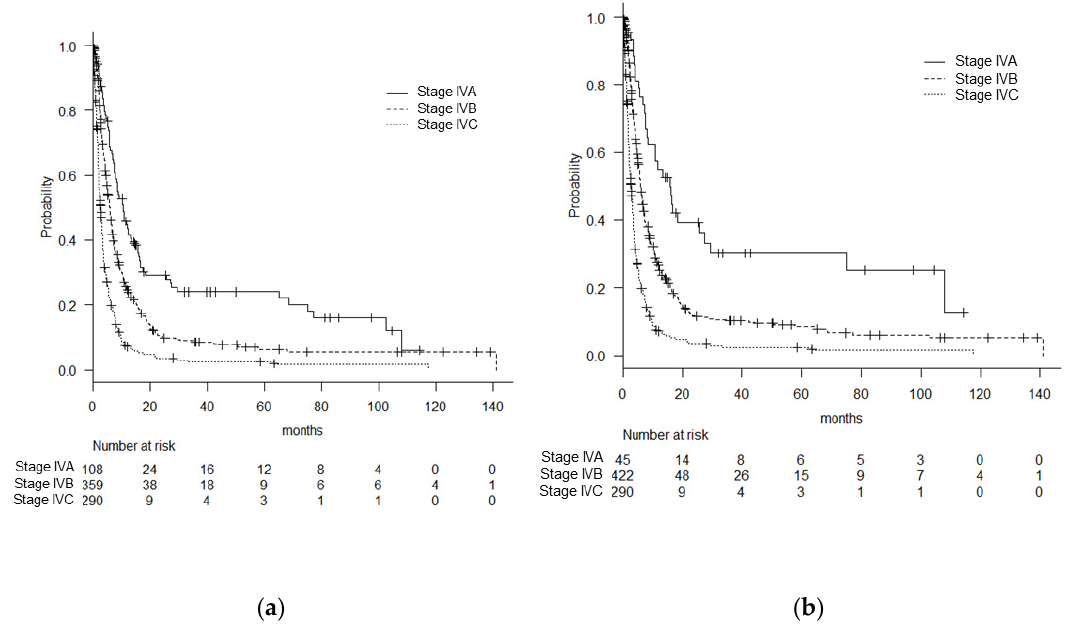
Figure 2. The OS of the patients according to the disease stage stratified by the American Joint Committee on Cancer/Union for International Cancer Control tumor–node–metastasis (AJCC/UICC TNM) classification, 7th edition ( a ) and 8th ( b ) edition. Table 4. The 3-, 6-, and 12-month OS rates of the ATC patients according to disease stage stratified by the 7th or 8th edition AJCC/ UICC TNM classification.